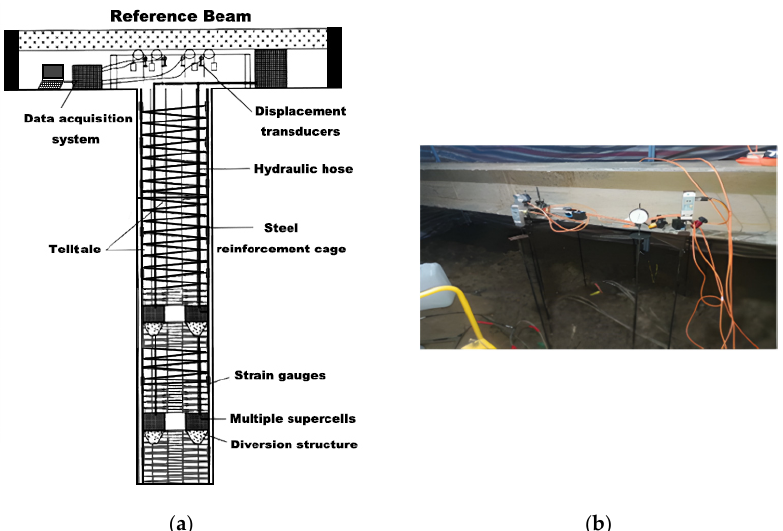
Figure 5. ( a ) Automatic data acquisition system ( b ) displacement transducers on the reference